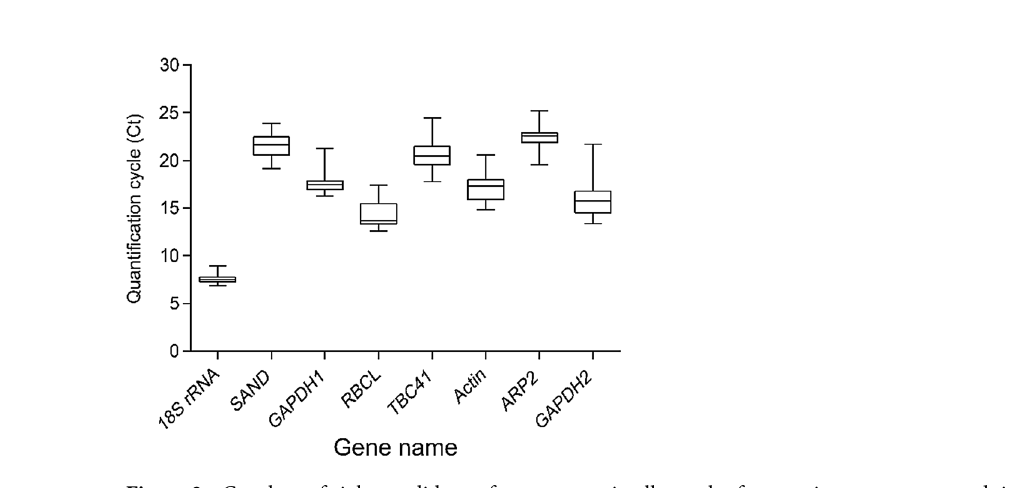
Figure 2. Ct values of eight candidate reference genes in all samples from various treatments and tissues. Boxes indicate the 25th and 75th percentiles in all samples; lines across the boxes represent the median; and the whisker caps represent the maximum and minimum values. The figure was generated by GraphPad Prism 9 (version 9.0.0; https ://www.graph